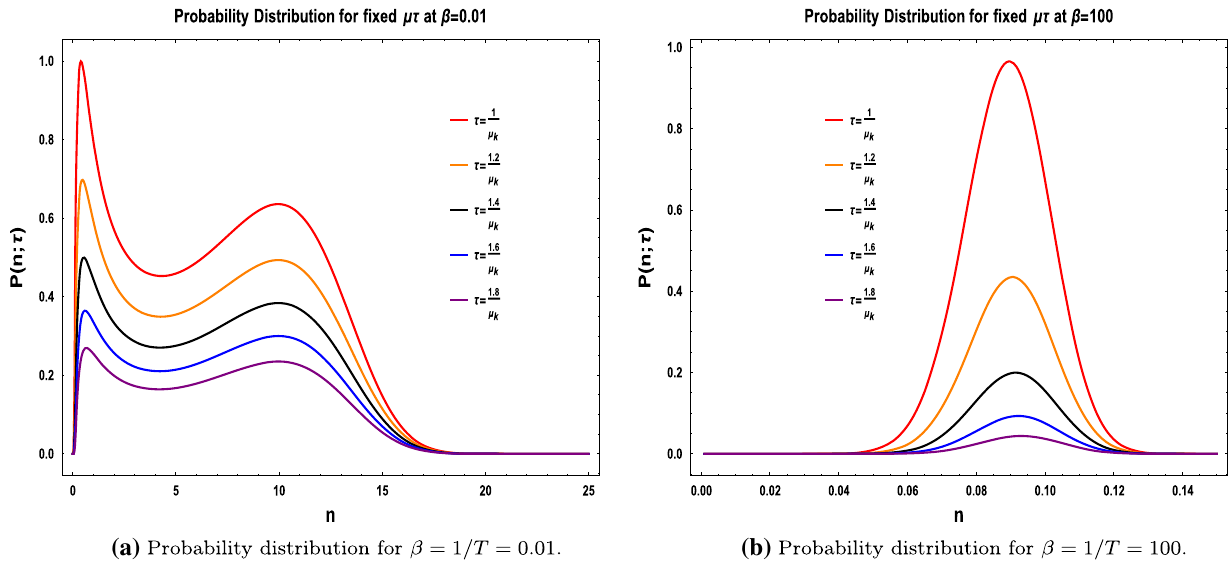
Fig. 4 Variation of the probability density function with respect to the the occupation number per mode at different